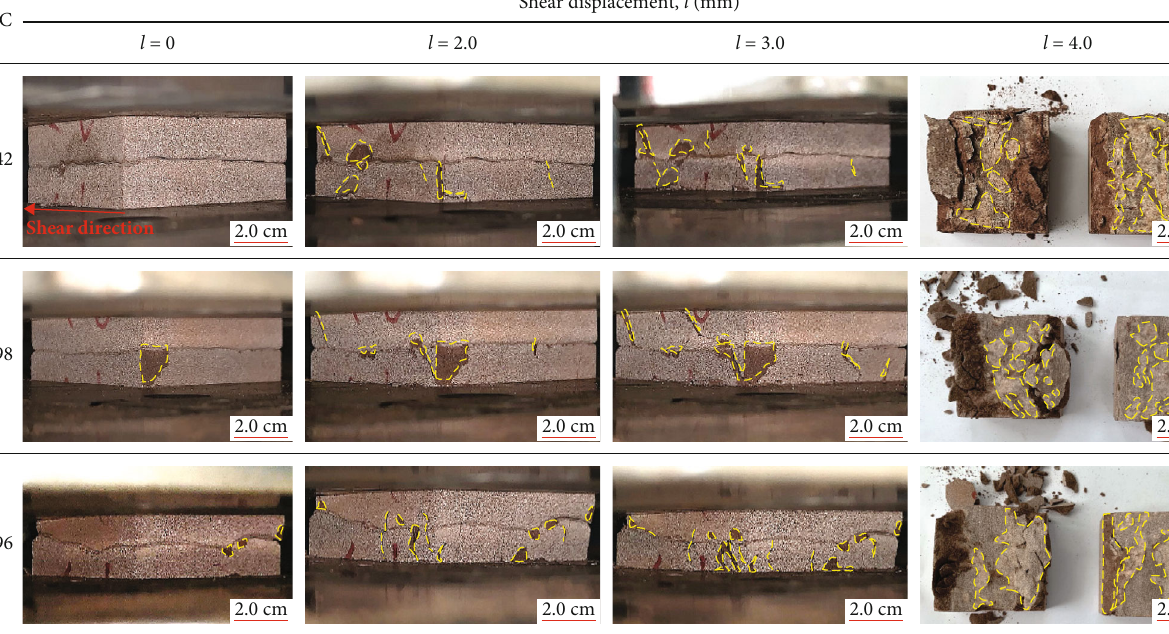
Figure 8: Shear failure process and damage zone of test joint specimens with di ff erent JRC values at normal stress of 15 MPa.